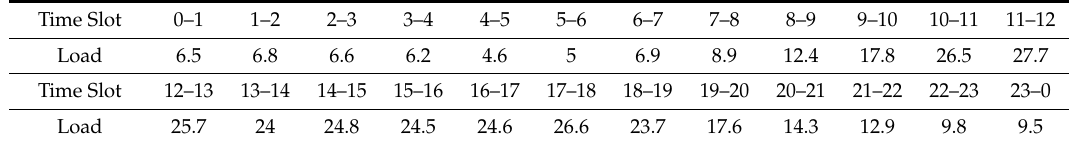
Table 5. The predicted values of power demand.